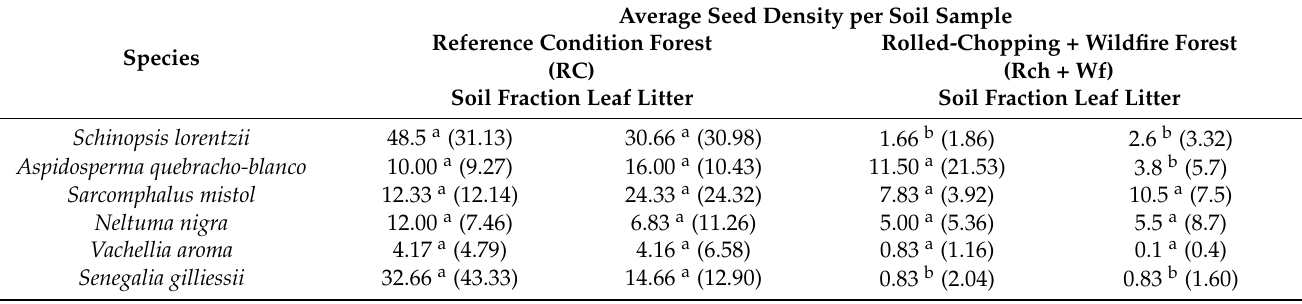
Table 5. Average seed density in soil and leaf litter fractions of six native woody species from Chaco- region forests with different land-management types. RC = reference condition forest, Rch + Wf = rolled-chopping and burnt